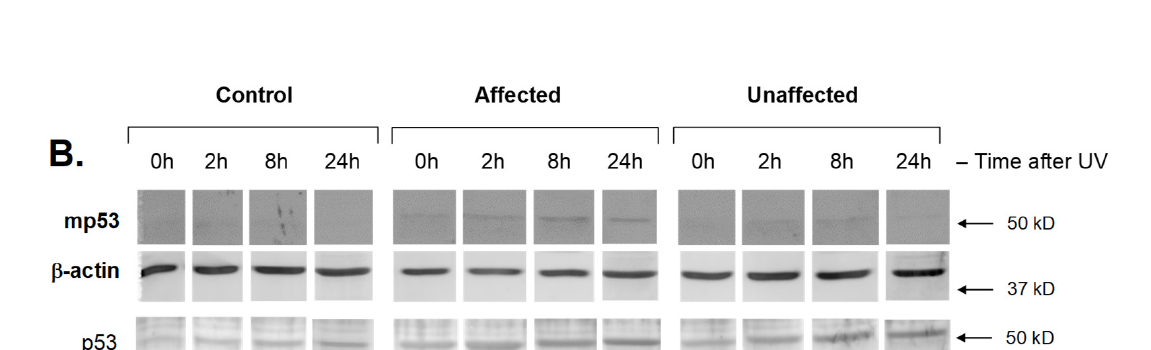
Figure 2. Mutant p53 (mp53) protein induction by dFb from affected LFS compared to unaffected or control subjects in response to UV exposure. Protein extracts of cultured dFb were subjected to immunoblot analysis following UV irradiation, as described. ( A ) Chemifluorescent signals corre- sponding to mp53 (53 kD) were normalized to those of β -actin (43 kD) following UV irradiation for each dFb source ( n = 8: * p < 0.05 affected vs. unaffected dFb; † p < 0.05, affected vs. control dFb; ‡ p < 0.05 unaffected vs. control dFb). ( B ) Results from representative immunoblot.